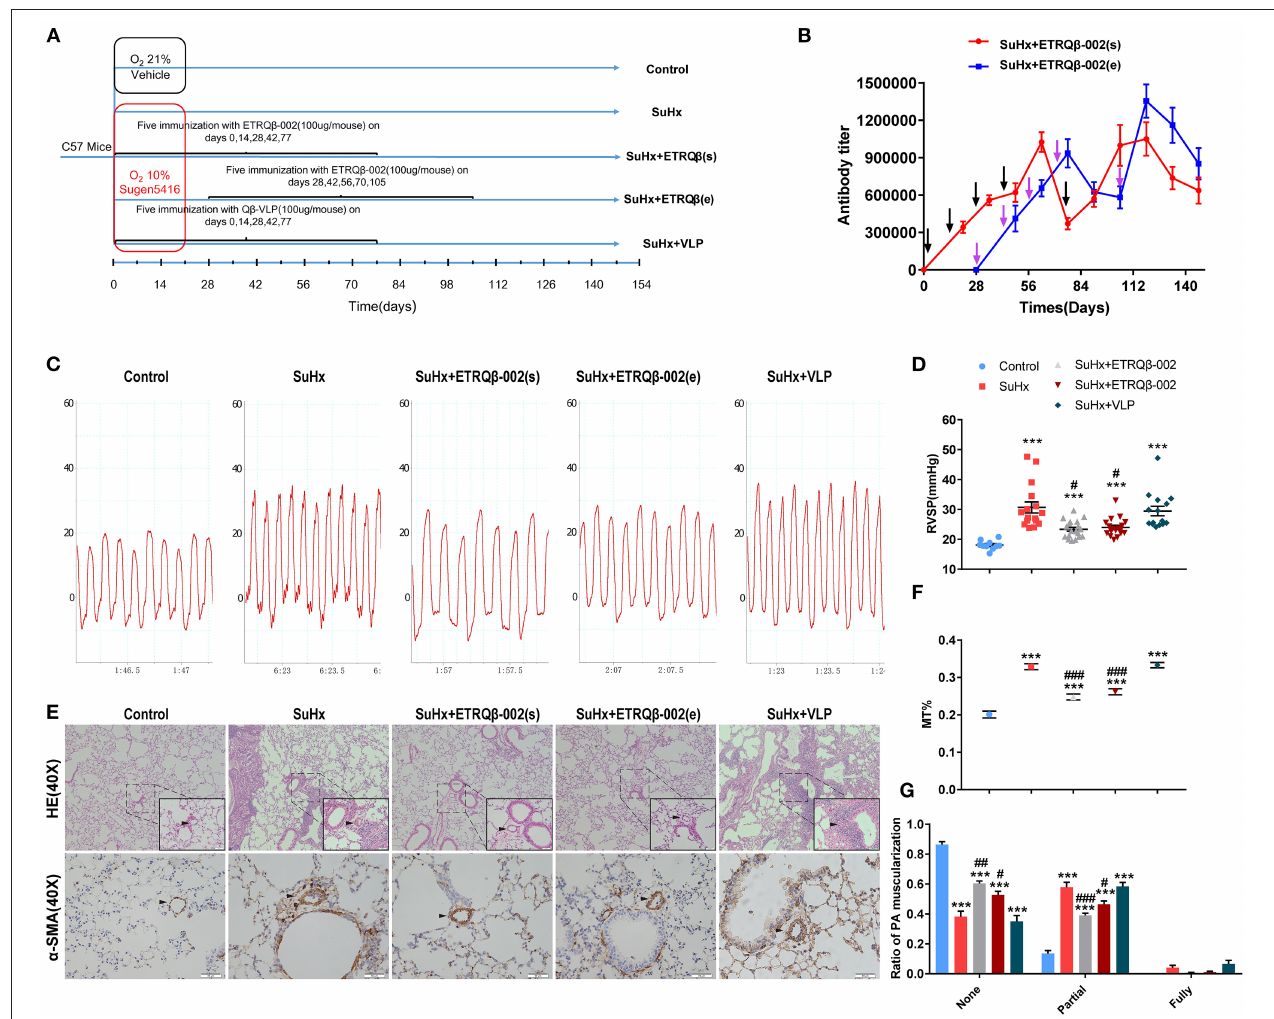
FIGURE 1 | Long-term efficacy of ETRQ β -002 vaccine in SuHx-induced PAH mice. (A) The progress map of SuHx-induced mice PAH model. (B) The ETRQ β -002 specific antibody titers were screened on days 21, 35, 49, 63, 77, 91, 105, 119, 133, and 147 in the SuHx + ETRQ β -002(s) group ( n = 10), whereas on days 49, 63, 77, 91, 105, 119, 133, and 147 in the SuHx + ETRQ β -002(e) group ( n = 10). The black and purple arrows refer to the ETRQ β -002 injections in the SuHx + ETRQ β -002(s) group and SuHx + ETRQ β -002(e) group, respectively. (C) Representative images of the pulmonary hypertension in the five groups. (D) RVSP measured by right cardiac catheterization on day 148 ( n = 10–19). (E) Representative photographs of hematoxylin-eosin (HE) and α -smooth muscle actin ( α -SMA) staining of lung sections from each group (scale bar = 50 µ m). (F) The percentage medial wall thickness (MT%) of vessels (diameter, 20–70 µ m; n = 8–10). (G) Ratio of